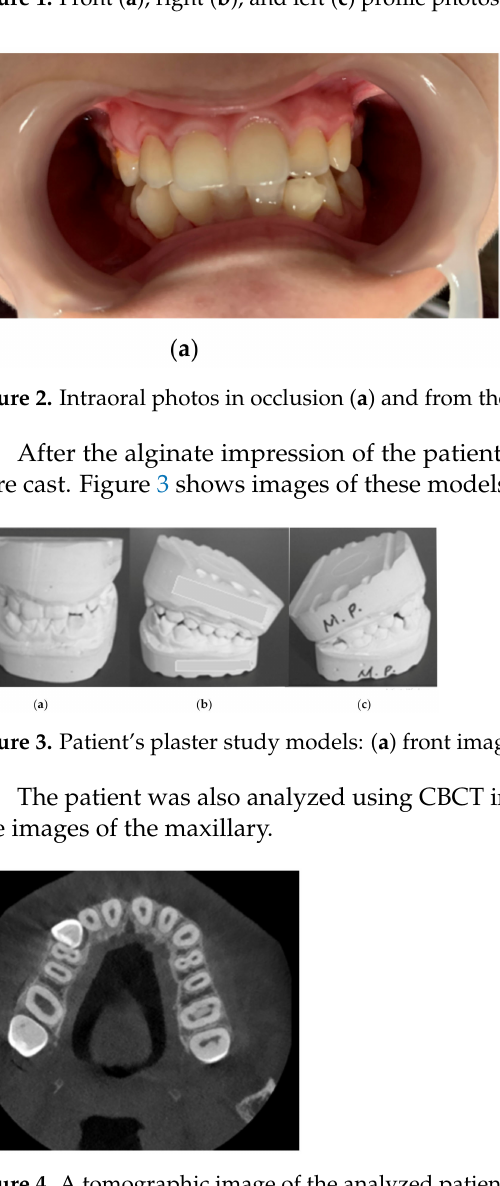
Figure 4. A tomographic image of the analyzed